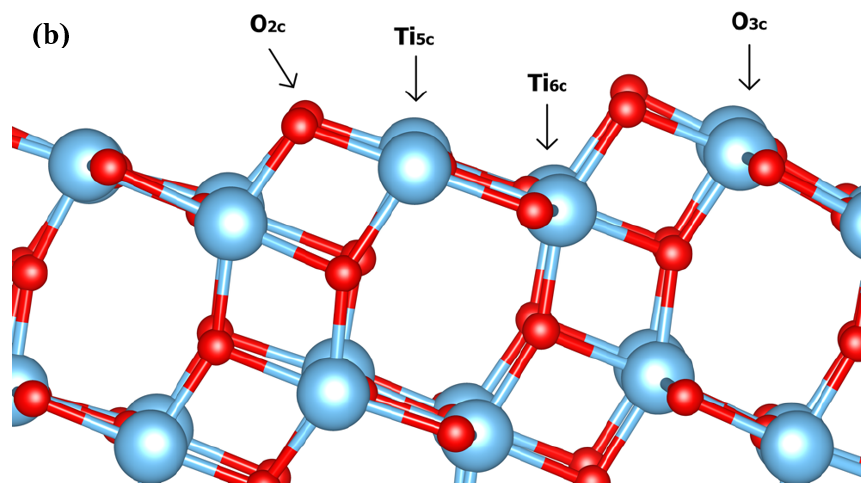
Figure 1. Structure of TiO 2 surfaces in the z ‐ direction ( a ) rutile (110) and ( b ) anatase (101). Where Ob is a bridging oxygen, O 3c a three ‐ coordinated surface oxygen, Ti 5c a penta ‐ coordinated surface Ti atom, and Ti 6c a hexa ‐ coordinated Ti atom.